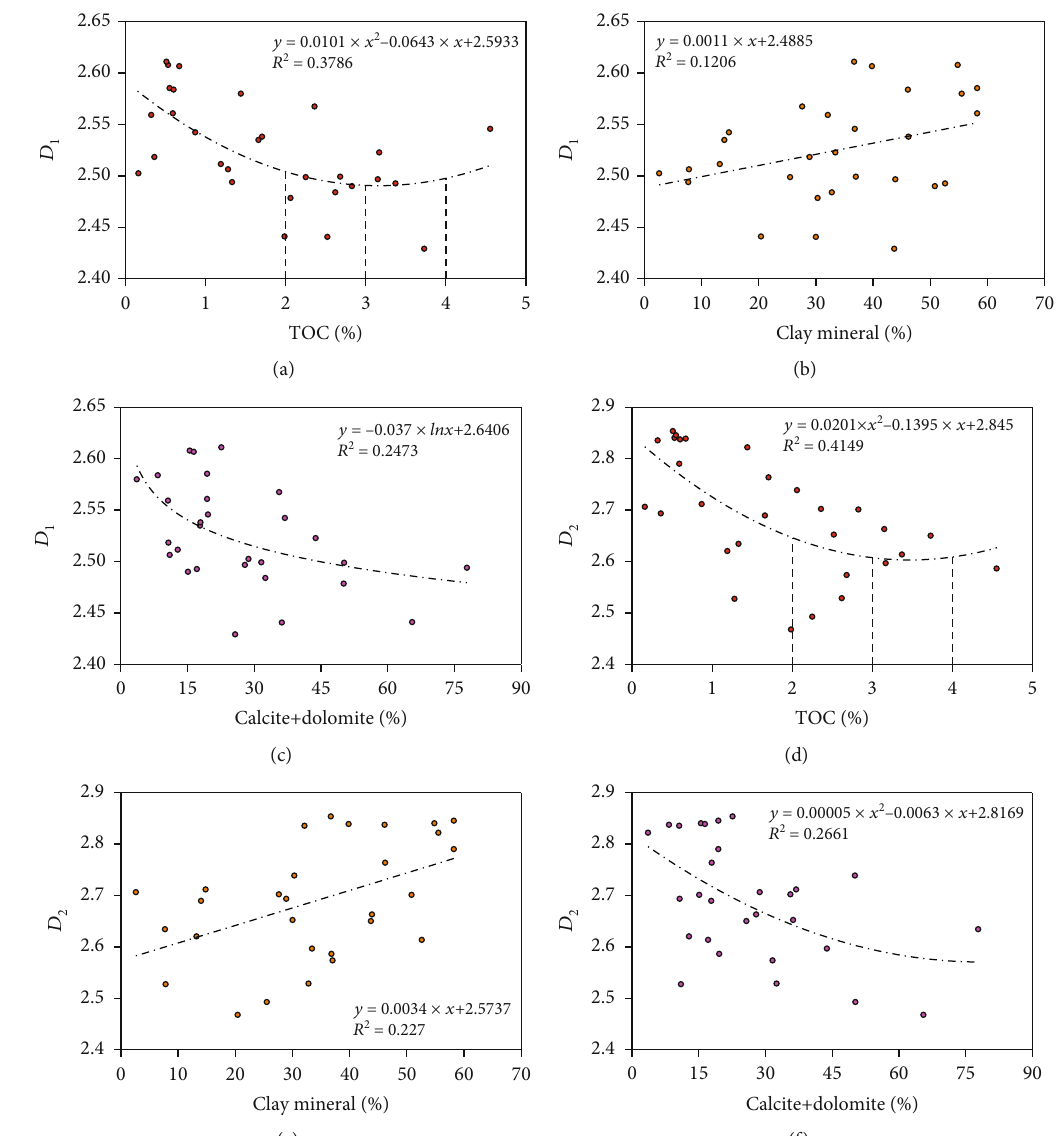
Figure 11: Relationships between fractal dimensions and TOC and mineralogical